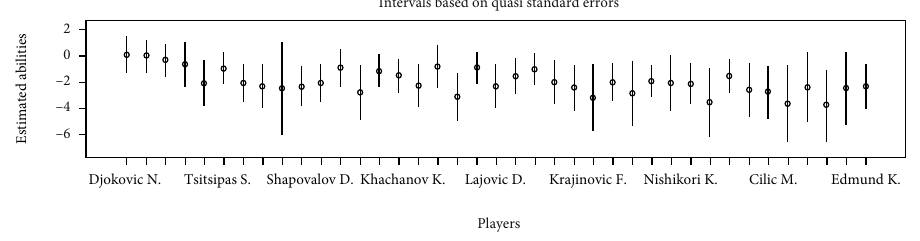
Figure 8: Estimated relative abilities of tennis players on clay court. Table 6: Wining probabilities of players on clay court. DN: Djokovic N.; NR: Nadal R.; TD: Thiem D.; FR: Federer R.; WS: Wawrinka S.; GC: Garin C.; RA: Rublev A.; TS: Tsitsipas S.; RC: Ruud C.; SD: Schwartzman D.